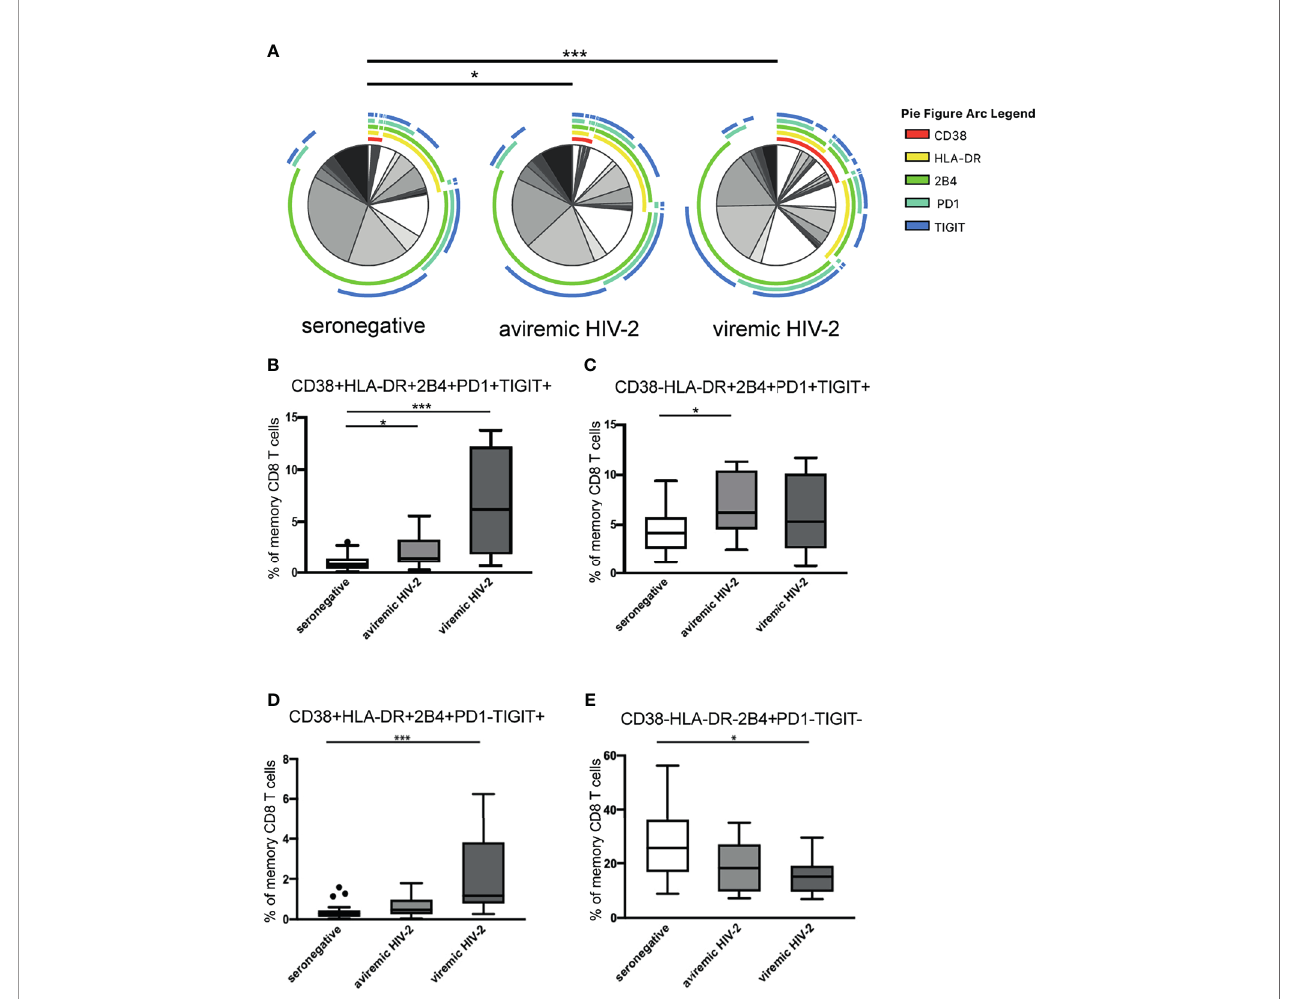
FIGURE 3 | Frequencies of memory CD8 T-cells co-expressing activation and inhibitory checkpoint markers. (A) Pie-charts illustrating SPICE analysis, where arcs show the analyzed markers and the pie-sectors the relative frequency of the memory CD8 T-cell populations positive for the markers, and tukey box plots illustrating frequencies of speci fi c memory CD8 T-cell populations being (B) CD38+HLA-DR+ 2B4+PD-1+TIGIT+, (C) CD38-HLA-DR+ 2B4+PD-1+TIGIT+, (D) CD38+HLA-DR+ 2B4+PD-1-TIGIT+ or (E) CD38-HLA-DR-2B4+PD-1-TIGIT- in seronegative participants (n = 27), treatment-naïve aviremic (n = 14) and viremic (n = 9) HIV-2-infected individuals. Permutation test was performed in the SPICE analysis and Kruskal Wallis test with Dunn´s post-test was performed for statistical comparisons of speci fi c CD8 T-cell populations between the groups. *p < 0.05 and ***p <